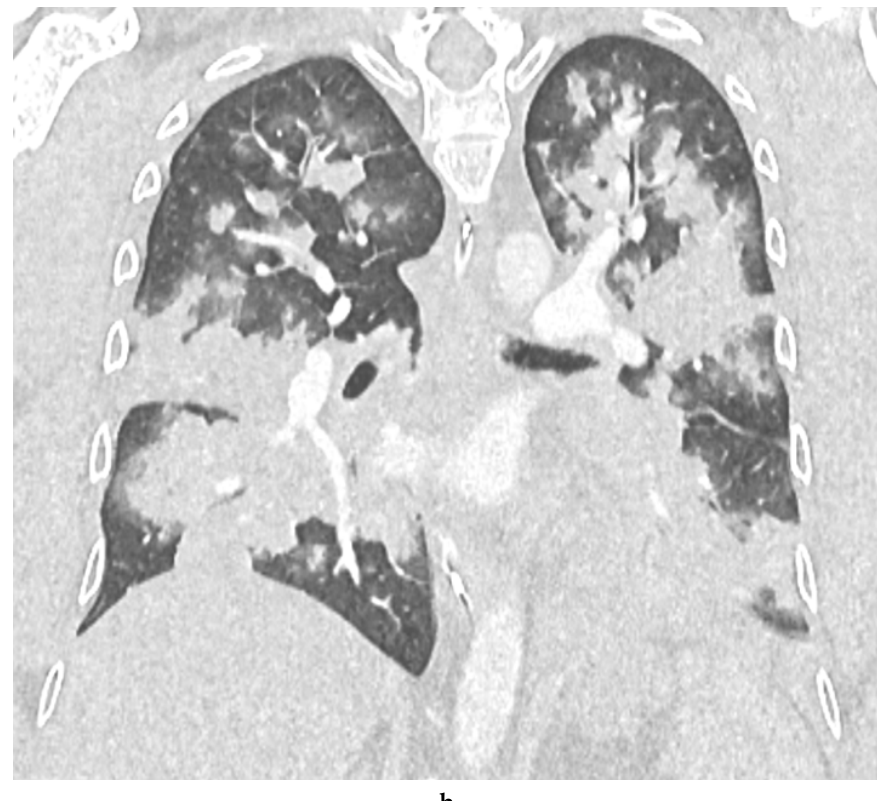
Figure 1. A 42 ‐ year ‐ old male presented with petechiae and the deterioration of general condition. The initial laboratory workup was especially notable for hemoglobin 6.9 g/dL and thrombocytes 1 G/L. Laboratory testing was positive for Anti ‐ GPIb/IX ‐ antibodies, consistent with the diagnosis of primary immune thrombocytopenia. Dexamethasone for 3 days was started. Six days later, during hospitalization